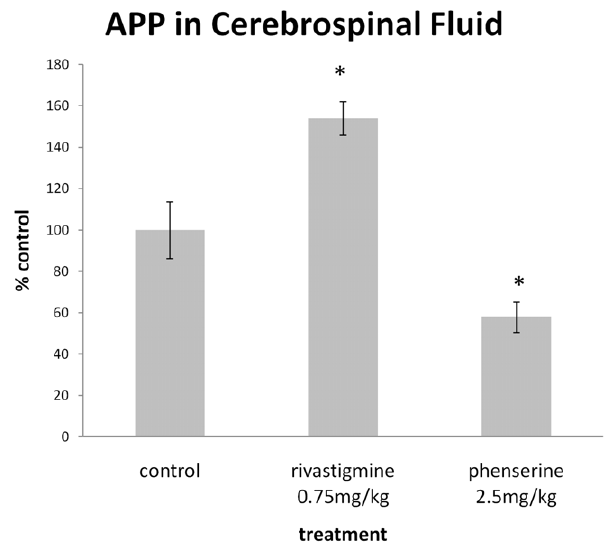
Figure 8. Rivastigmine elevates CSF sAPP levels in rodents. Separate groups of Fischer-344 male rats (n=8–12) were administered saline (control) or rivastigmine (0.75 mg/kg) i.p. once daily for 21 days, and CSF was collected within 120 min of the final dose for quantification of sAPP by Western blot analysis probing with anti-APP antibody, 22C11. The APP synthesis inhibitor, phenserine (2.5 mg/kg, i.p. for 21 days) was administered to a concurrent group of animals as a positive control (* , 0.05 vs control, Dunnett’s